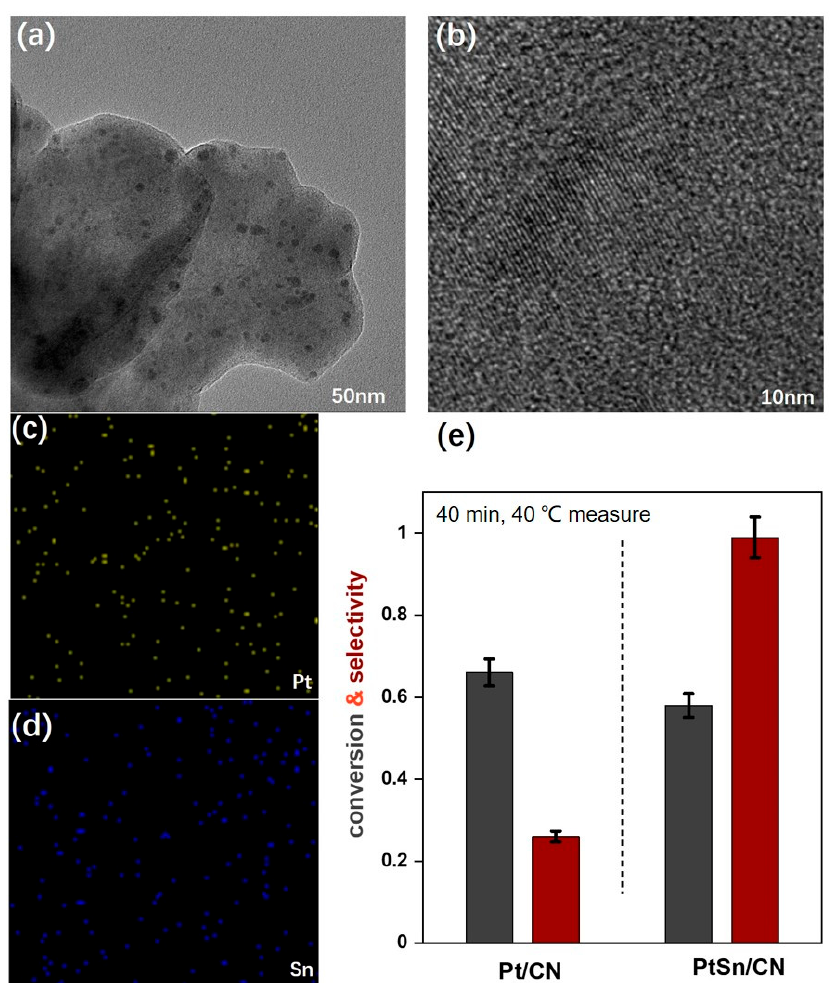
Figure 8. Transmission electron microscope (TEM) images of PtSn/CN at different scales: ( a ) 50 nm; ( b ) 10 nm. Scan of the atomic distribution of Pt and Sn on the TEM: ( c ) Pt; ( d ) Sn. ( e ) The hydrogenation performance results of Pt/CN and PtSn/CN catalytic nitrostyrenes on 40 min at 40 °C with 8 bar hydrogen pressure.